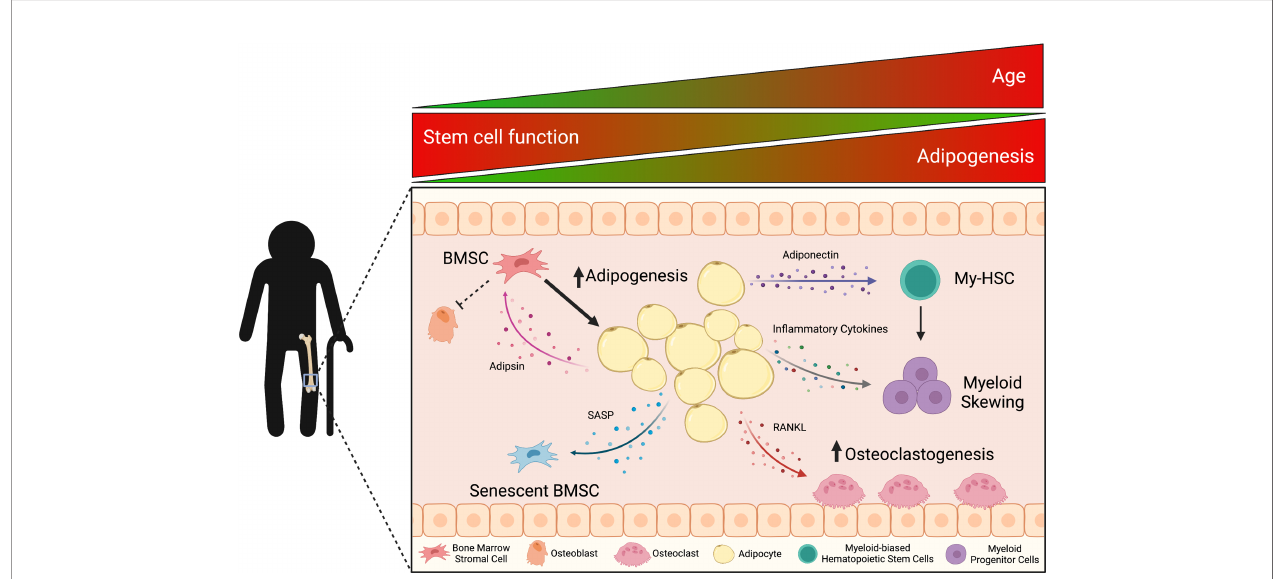
FIGURE 1 | With age, the accumulation of bone marrow adipocyte (BMAd)-derived factors in fl uences mechanisms of bone remodeling, hematopoiesis, and in fl ammation, which triggers a cascade effect within the bone marrow (BM) microenvironment. Aging is associated with increased bone marrow adiposity (BMA) and decreased bone mineral density. These classic characteristics of aging result from adipsin priming bone marrow stromal cells (BMSCs) towards adipogenesis and adipocytes (including pre-adipocytes in aged mice) secreting the pro-osteoclastic factor, RANKL. Adipocytes also secrete adiponectin and pro-in fl ammatory cytokines that skew hematopoietic stem cell differentiation towards the myeloid lineage, which is observed in the chronic in fl ammatory state of aging (in fl ammaging). In the BM, this pro-in fl ammatory microenvironment leads to senescence-associated secretory phenotype (SASP) factors decreasing BMSC potential and functionality. This fi gure was created using BioRender.com